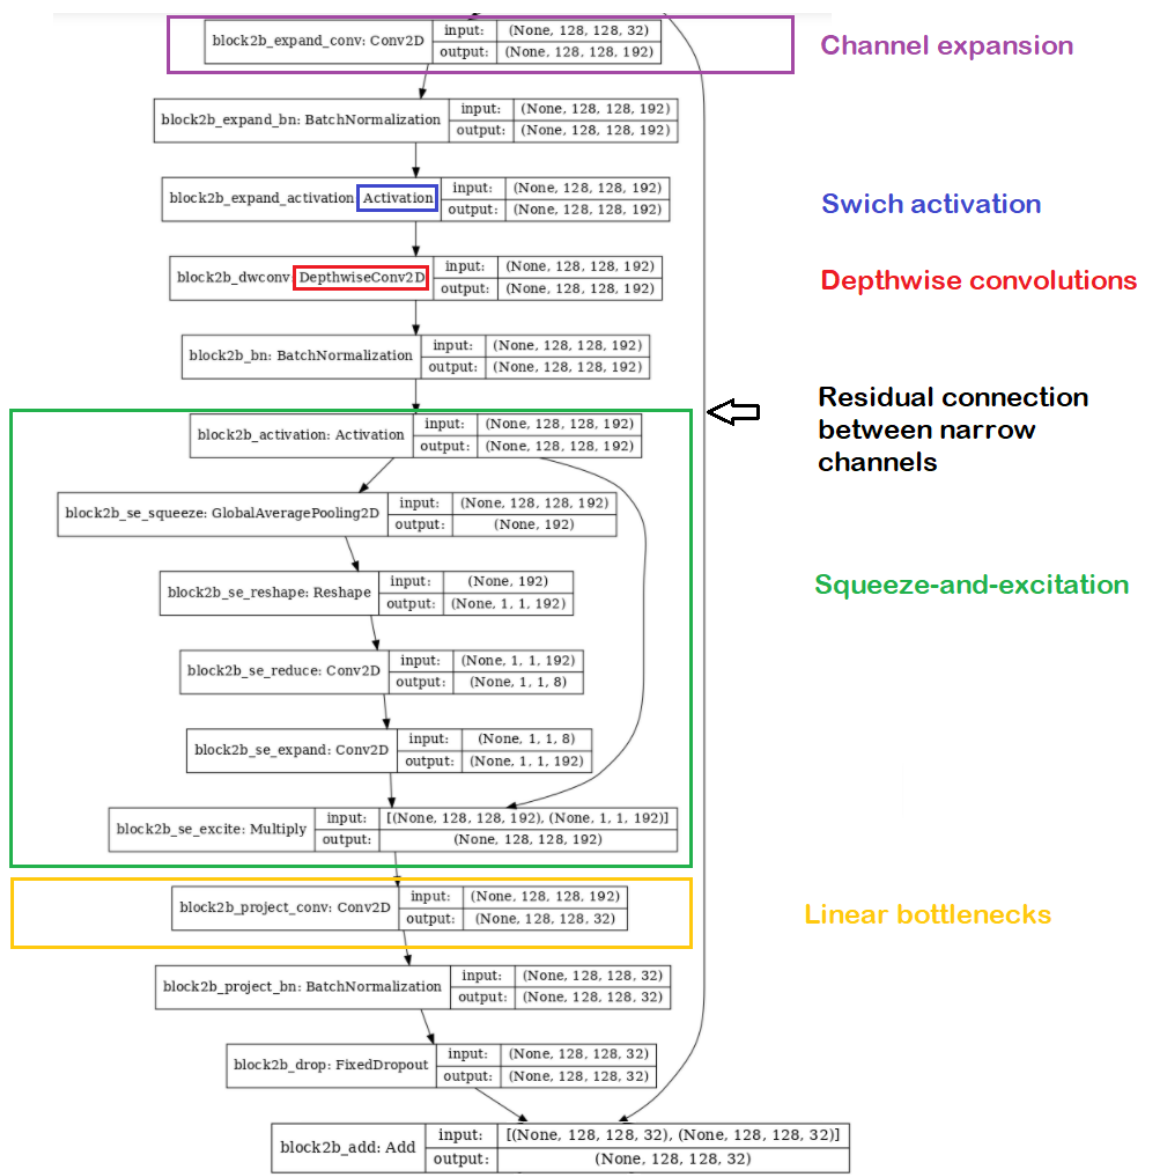
Figure 4. Illustration of MBConv6 with Squeeze-and-Excitation block and inverted residual